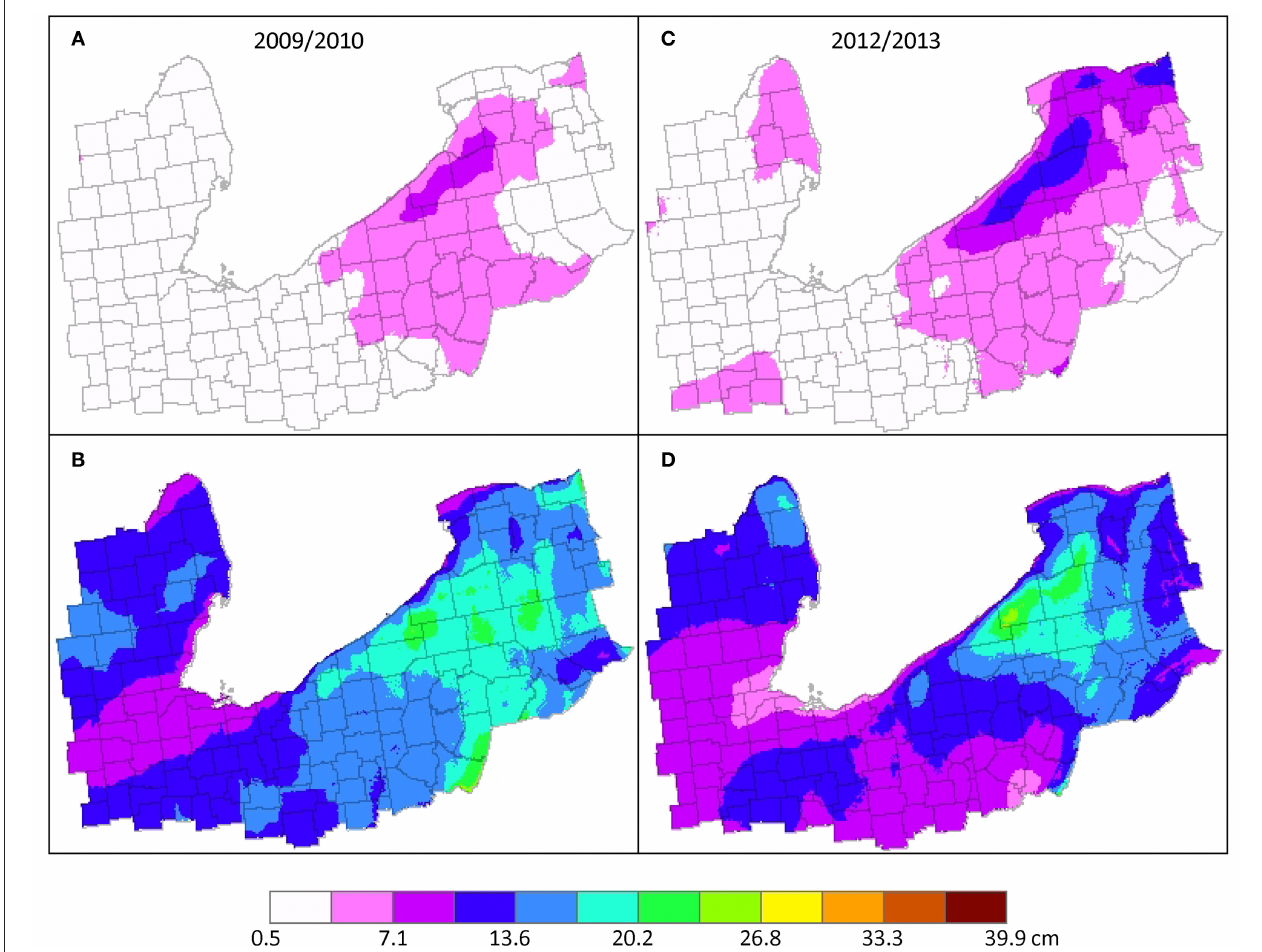
FIGURE 3 | The 2009/2010 cold-season LWE snowfall (cm) for (A) LES days and (B) non-LES days and the 2012/2013 cold-season LWE snowfall for (C) LES days and (D) non-LES days in the vicinity of Lake